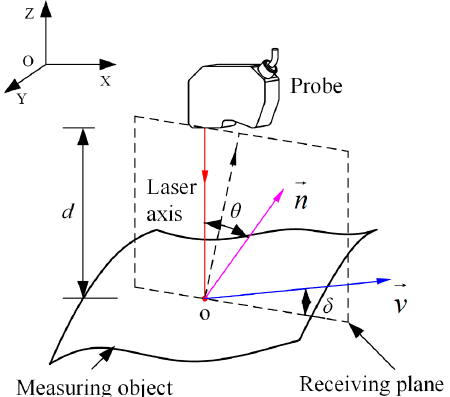
Figure 4. The definition of probe’s position and orientation parameters.